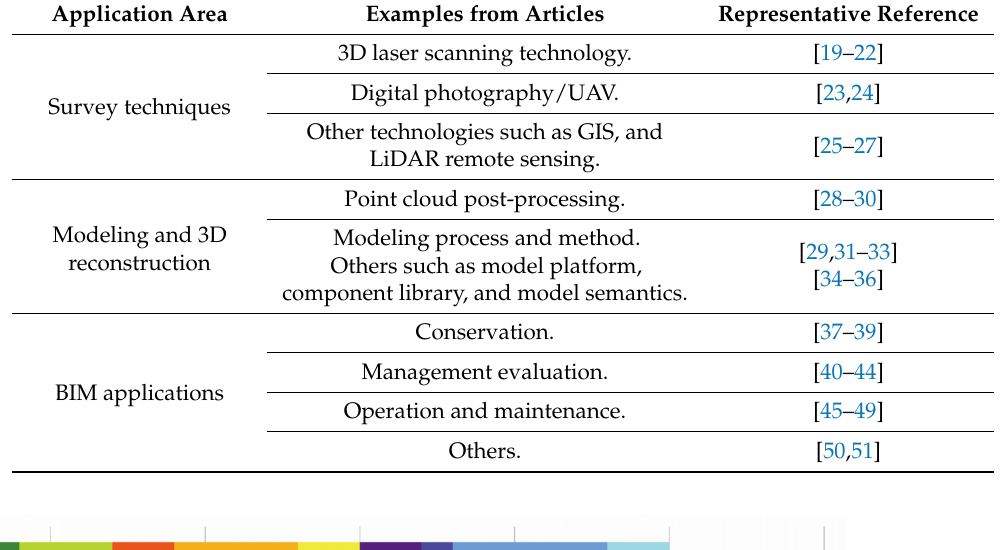
Table 4. Application field of BIM in architectural heritage.